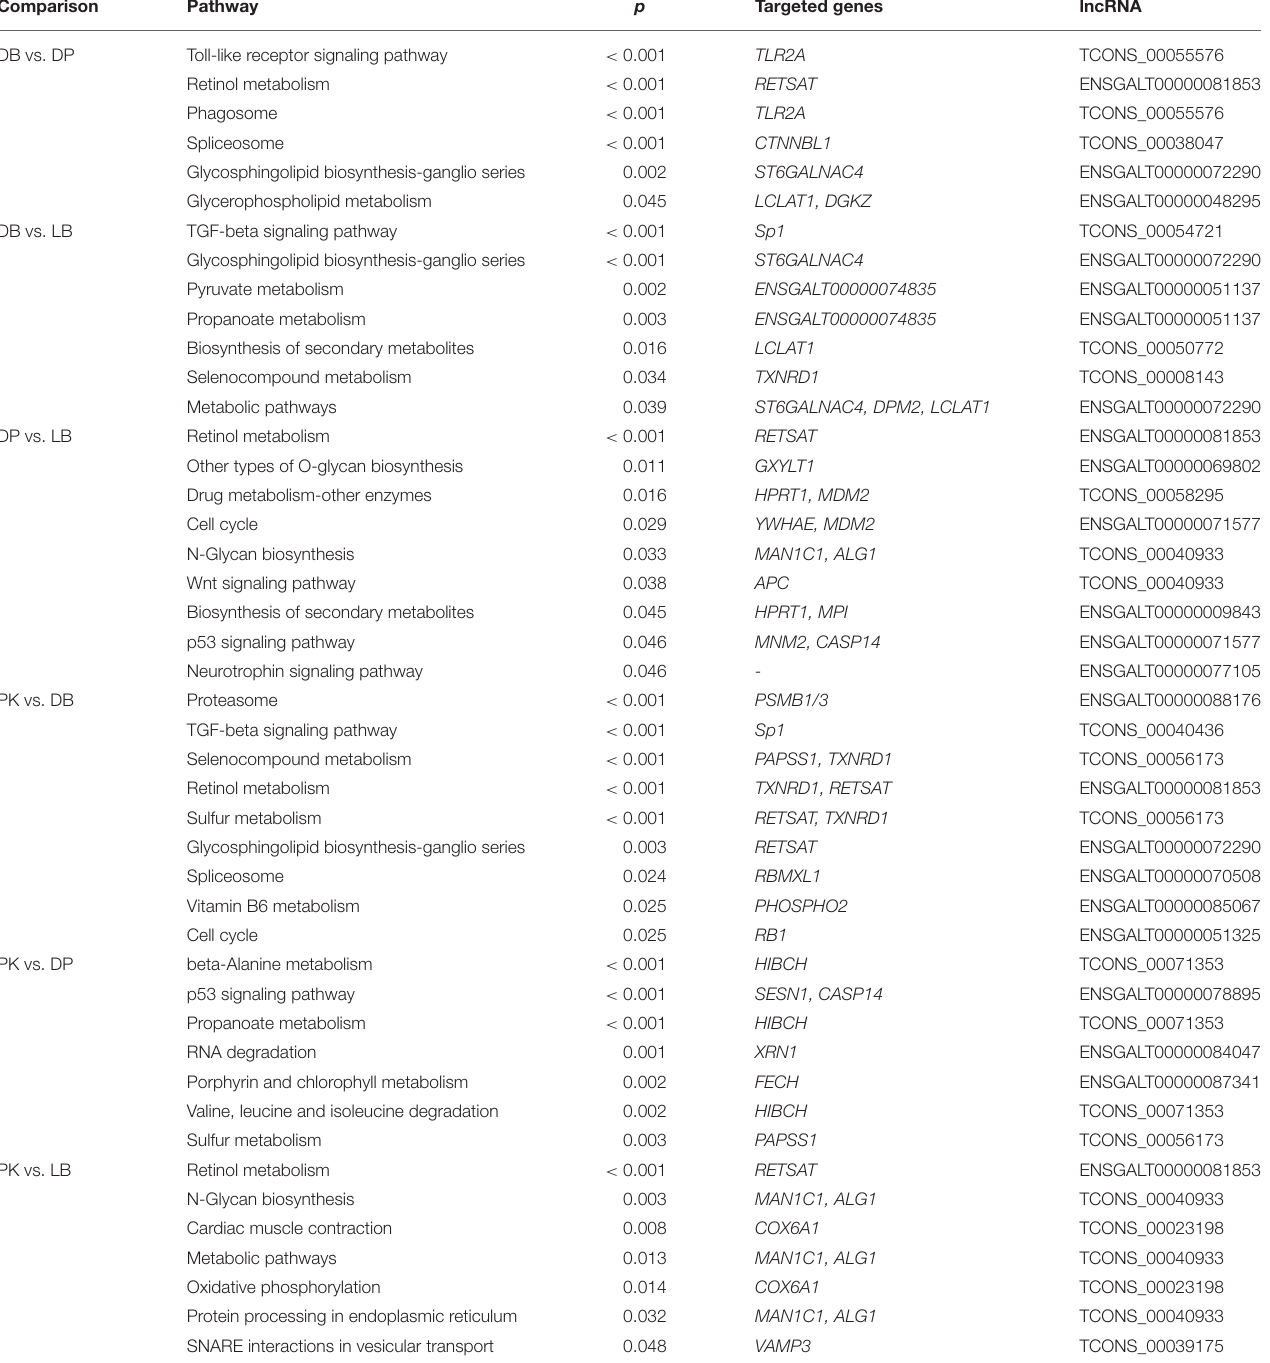
TABLE 3 | Differently enriched KEGG pathways with targeted genes of lncRNA of comparisons between chickens with different eggshell colors.